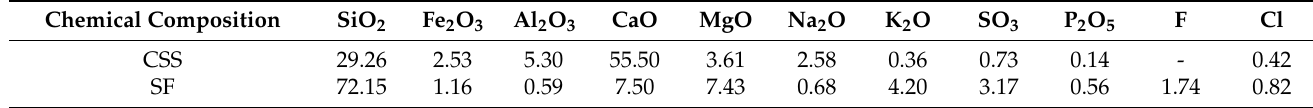
Table 1. Content of chemical composition for raw materials (mass fraction %)